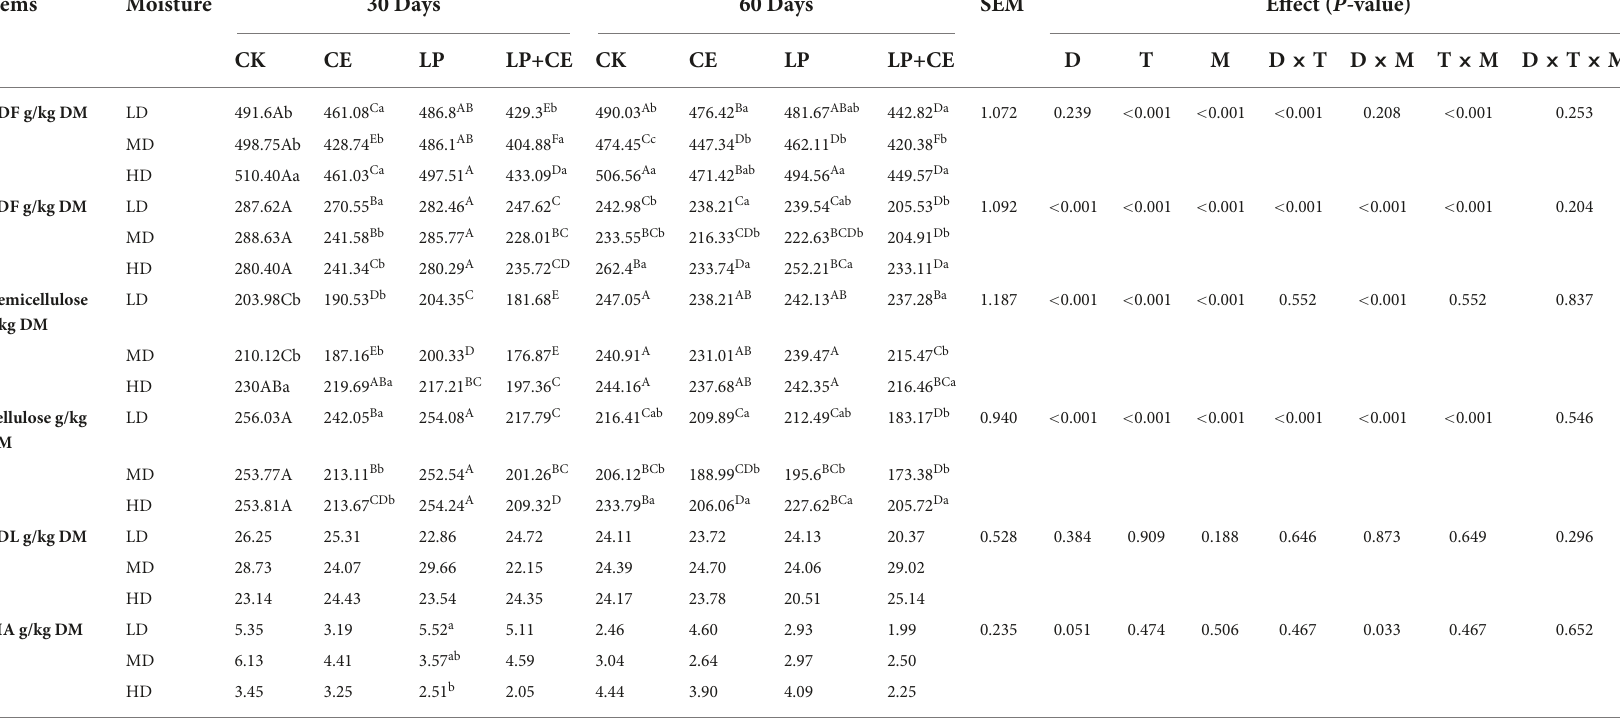
TABLE 4 Effects of additives and moisture content on structural carbohydrate concents.